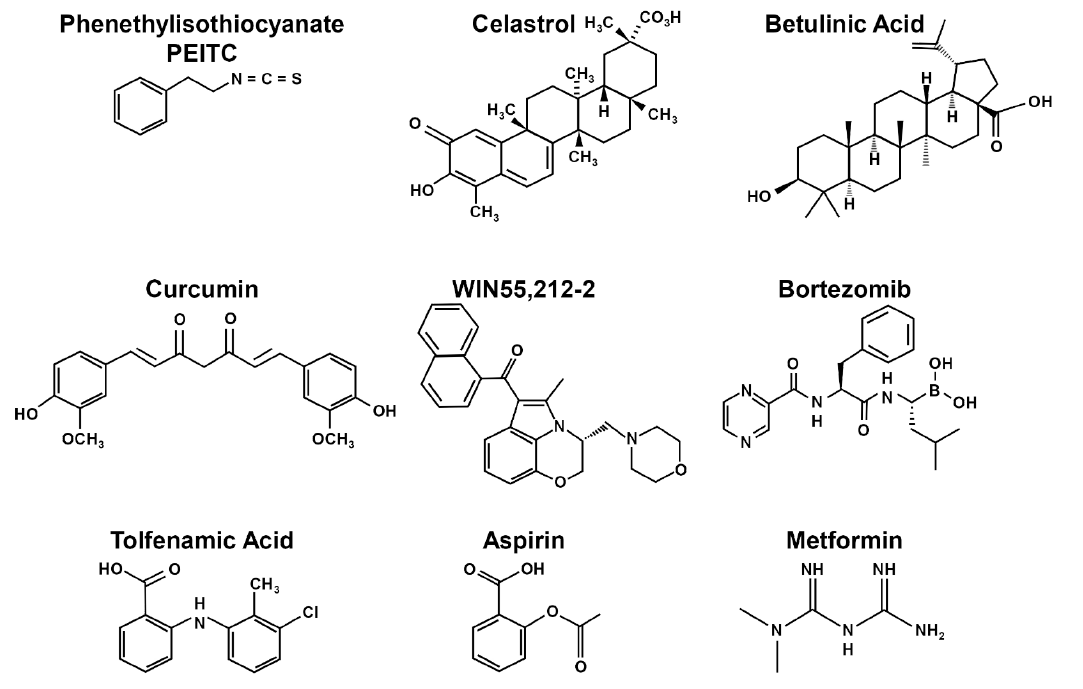
Figure 6. Structures of compounds that induce Sp downregulation. Compounds that induce down- regulation of Sp1, Sp3 and Sp4 are structurally diverse and include PEITC [151], celastrol [153], bet- ulinic acid [155,165,191], curcumin [154,158], WIN55,212-2 [190], bortezomib [179], tolfenamic acid